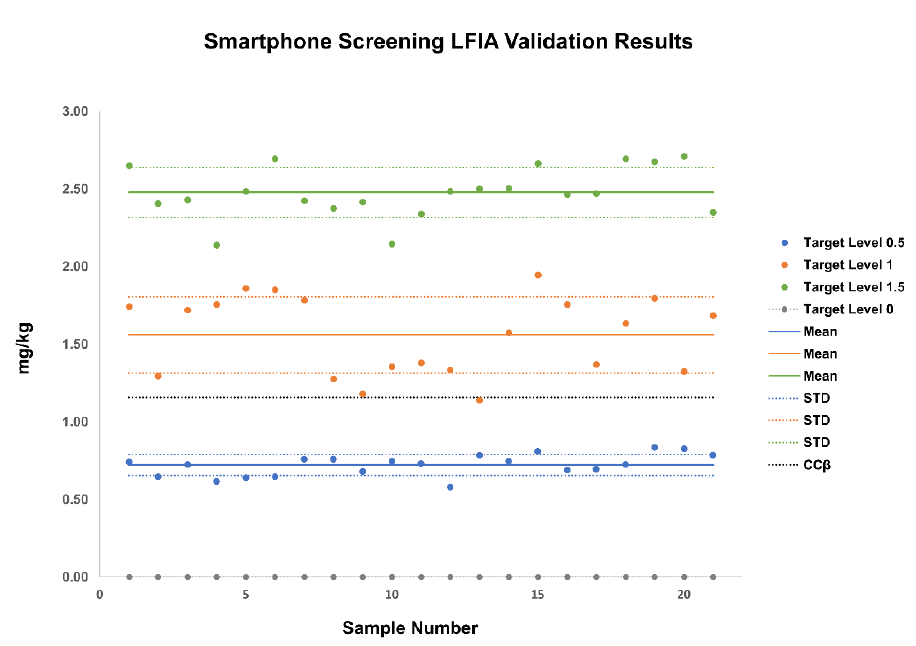
Figure 4. Data analysis of 21 blank wheat samples, and spiked versions thereof, at three target levels, demonstrating distinct differentiation between them in the screening LFIA. Quantification with the use of the smartphone app.